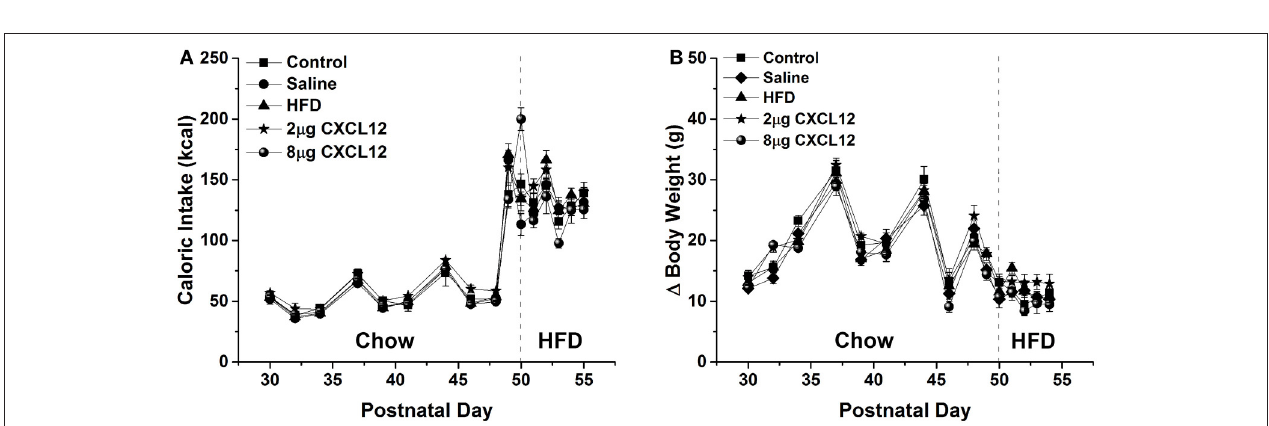
FIGURE 5 | Prenatal HFD and CXCL12 had no effect on caloric intake and body weight. The left of the dashed line represents maintenance on chow from P30-48 as measured every 2–3 days, while the right of the dashed line represents daily measurements of a 7-day HFD challenge from P50 to P57. (A) No effect in any of the treatment groups compared to control was seen in caloric intake during both the maintenance period and on the 7-day HFD challenge. (B) No effect in any of the treatment groups compared to control was seen on change in body weight during both the maintenance period and the 7-day HFD challenge.